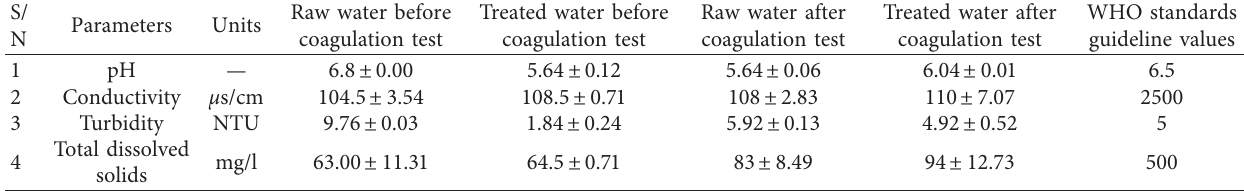
Table 5: Physicochemical analysis of influent raw and treated water before and after the evaluation of the efficiency of M . oleifera seed husk activated carbon coagulation test.